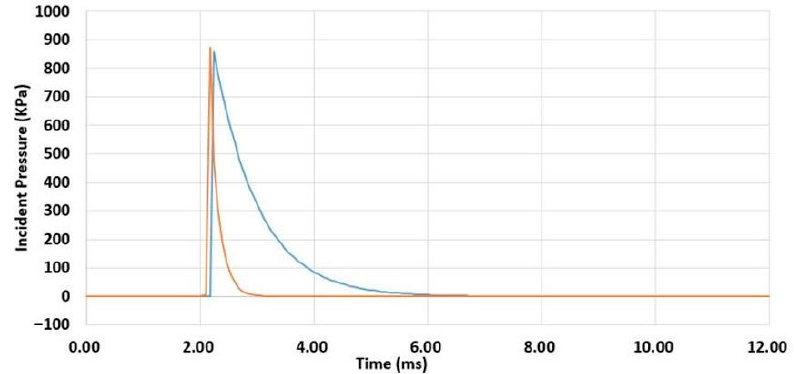
Figure 8. Incident pressure vs time curve from Conwep and LS-DYNA. Table 7. Compare peak pressure between ConWep and LS-DYNA.